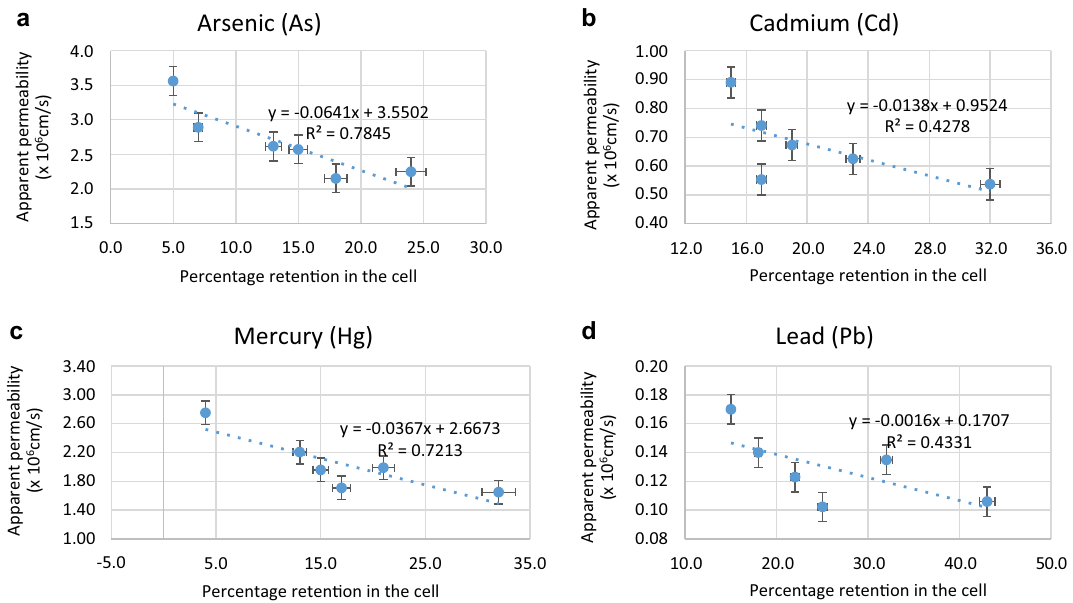
Figure 5. Relationships between percentage retention in the cell membrane and intestinal permeability of As, Cd, Hg and